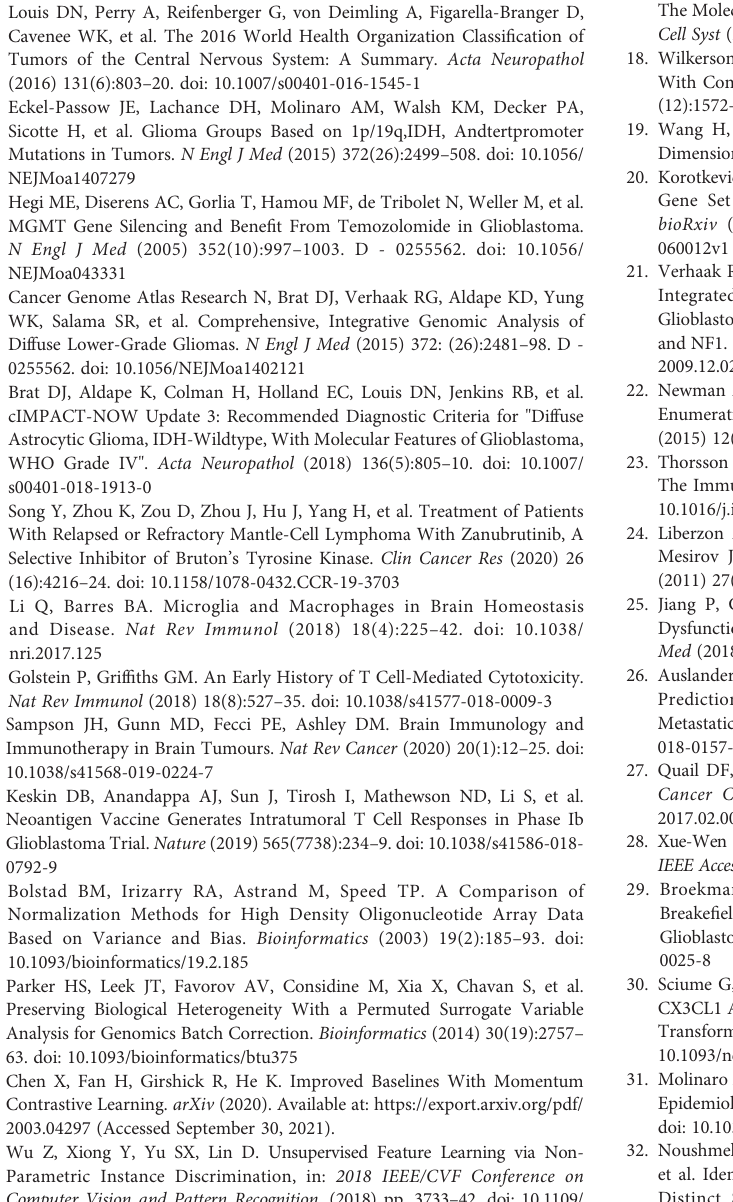
Supplementary Figure 10 | Kaplan-Meier survival analysis of C1/2 subtypes of glioblastoma with different treatment modalities. Supplementary Figure 11 | Kaplan-Meier analysis of progression-free survival differences of C1/2 subtypes in TCGA glioma cohort. Supplementary Figure 12 | Forest plot representation of multivariate Cox regression analyses in the combined, individual cohort, and different